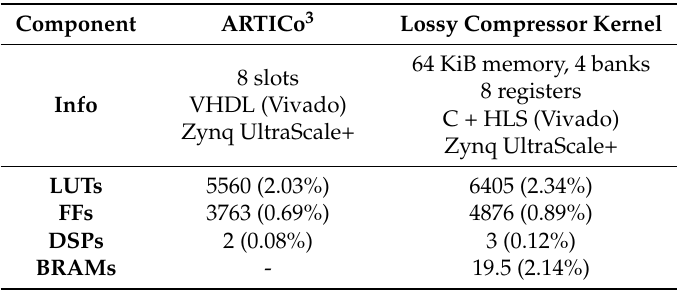
Table 4. Resource